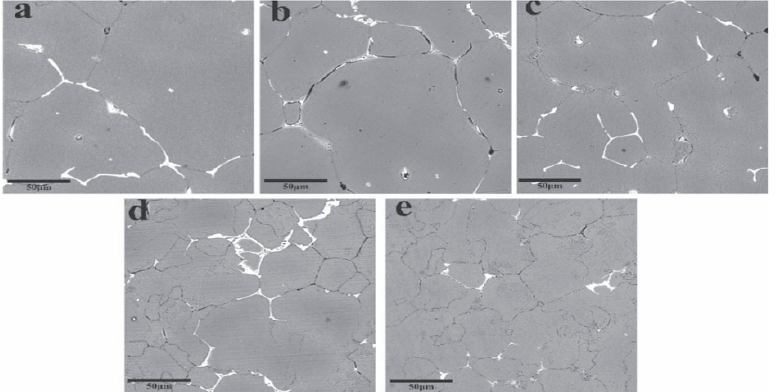
Figure 12. SEM images of 7055 as-cast alloys ( a ) Al-Y-0Sc, ( b ) Al-Y-0.2Sc, ( c ) Al-Y-0.25Sc, ( d ) Al-Y-0.3Sc, ( e ) Al-Y-0.35Sc. Adapted with permission from ref. [66]. 2021 Huang et al.